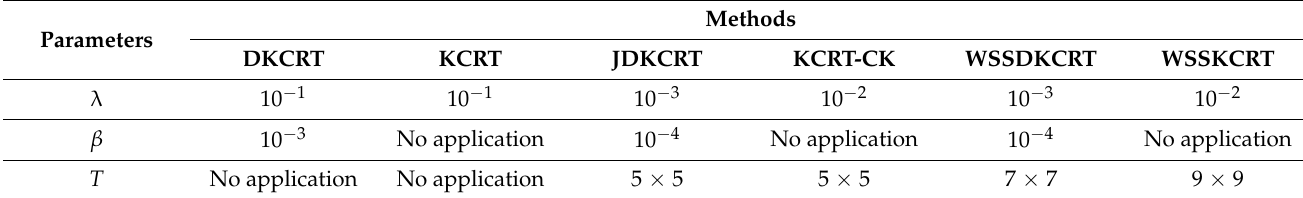
Table 3. Classification accuracy for land cover types.